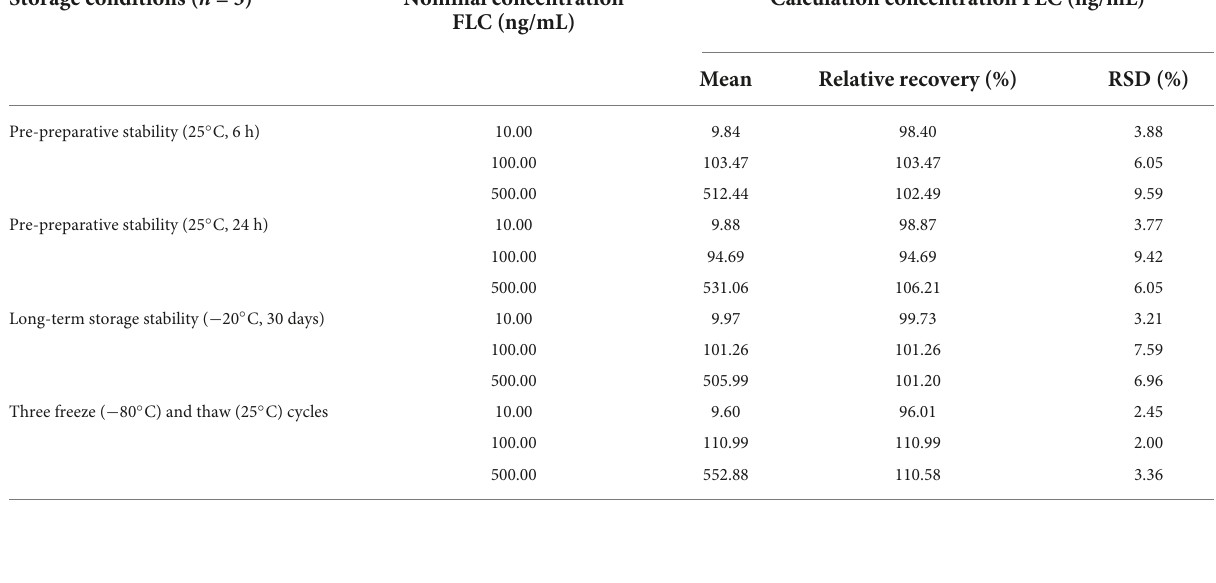
TABLE 5 Freeze thawing of FLC in C. albicans lysate samples ( n = 3).